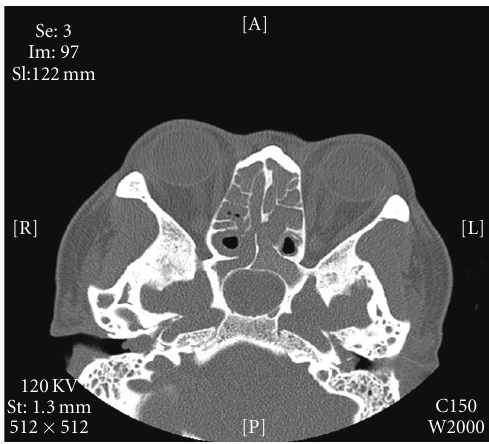
Figure 1: Axial computed tomographic scan demonstrates bilateral aural polyps with thickened sinonasal mucosa.